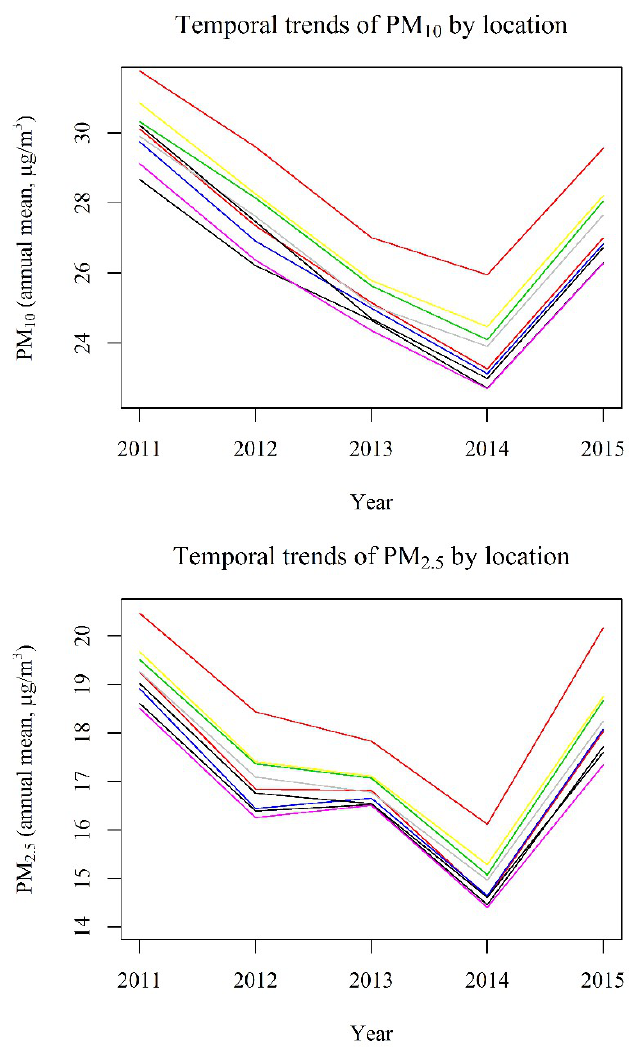
Figure 3. Observed temporal trends for the annual mean concentrations of PM from 2011 to 2015, in 10 randomly selected residential locations.